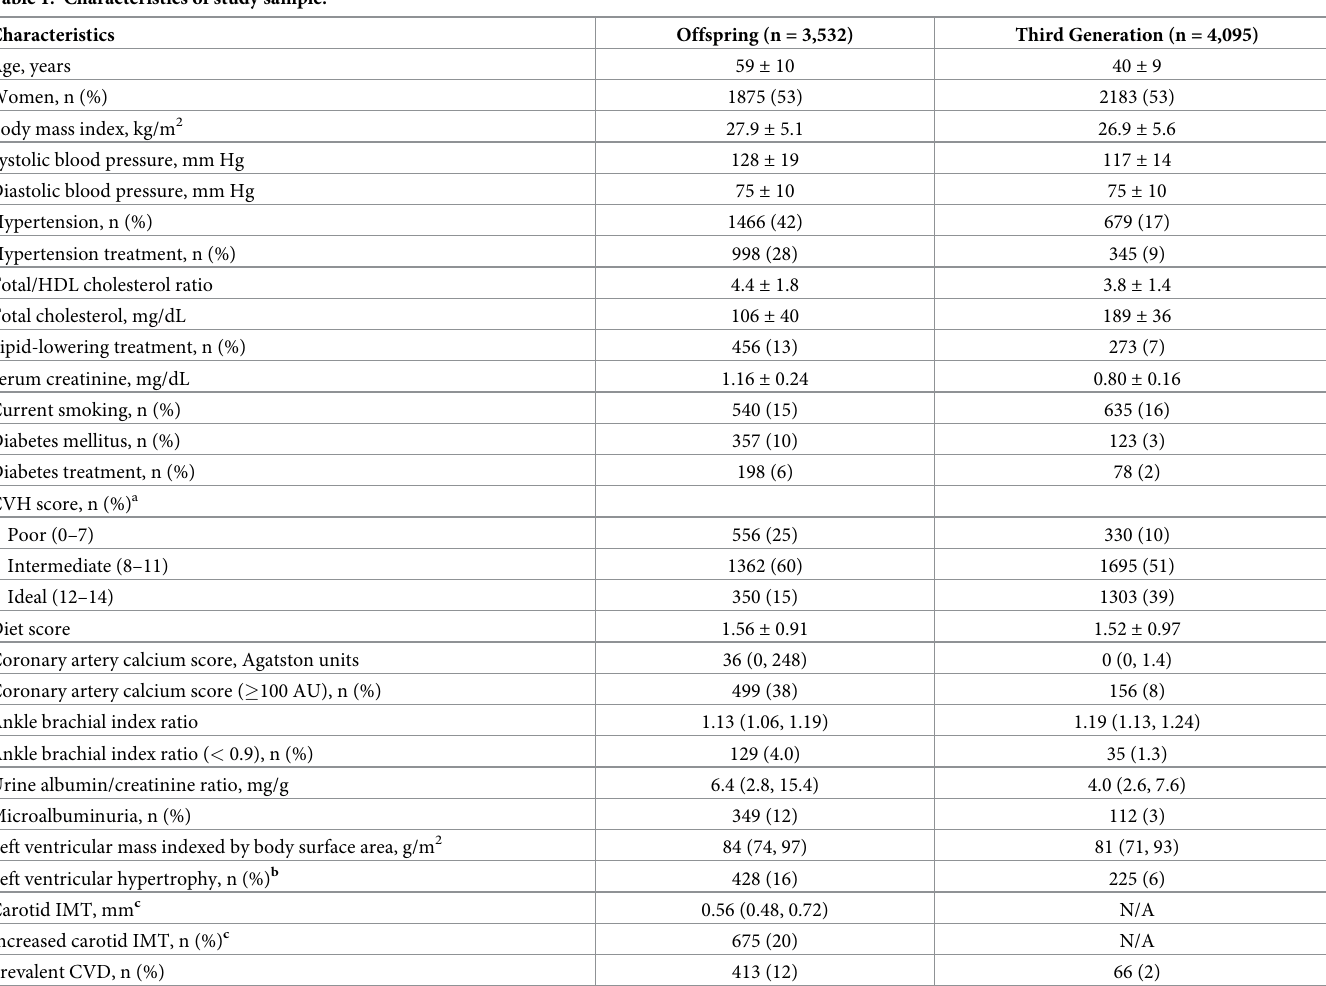
Table 1. Characteristics of study